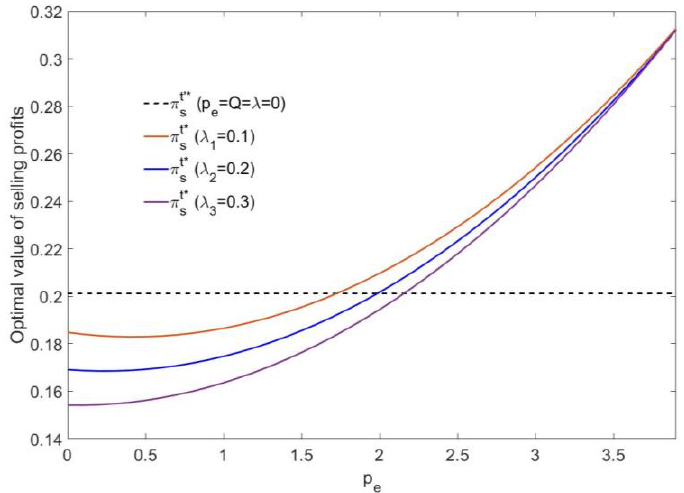
Figure 7. The effect of p e on the optimal selling profit ( Q 5 = 0.08).